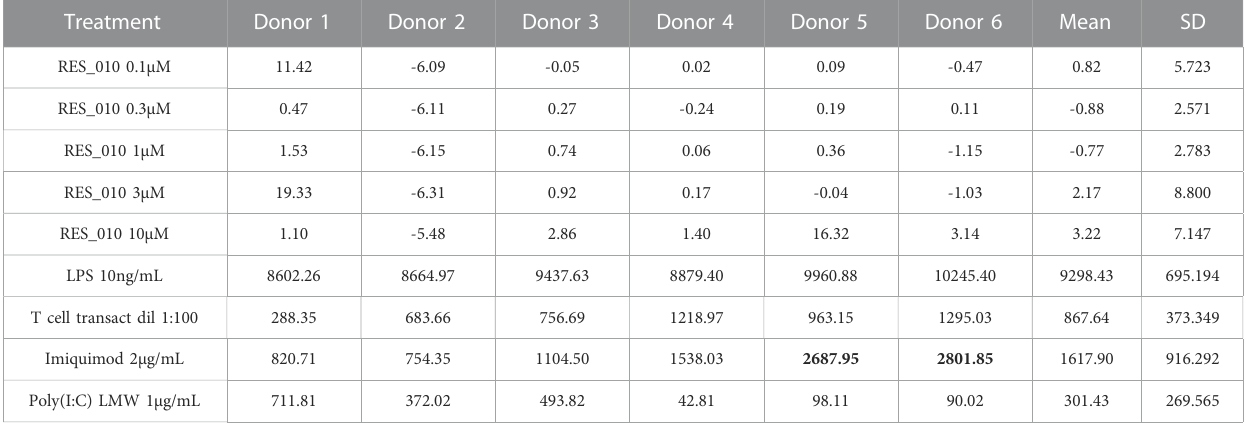
TABLE 6 Concentration Data Vehicle Corrected (pg/mL) for Cytokines: TNF α . Treatment